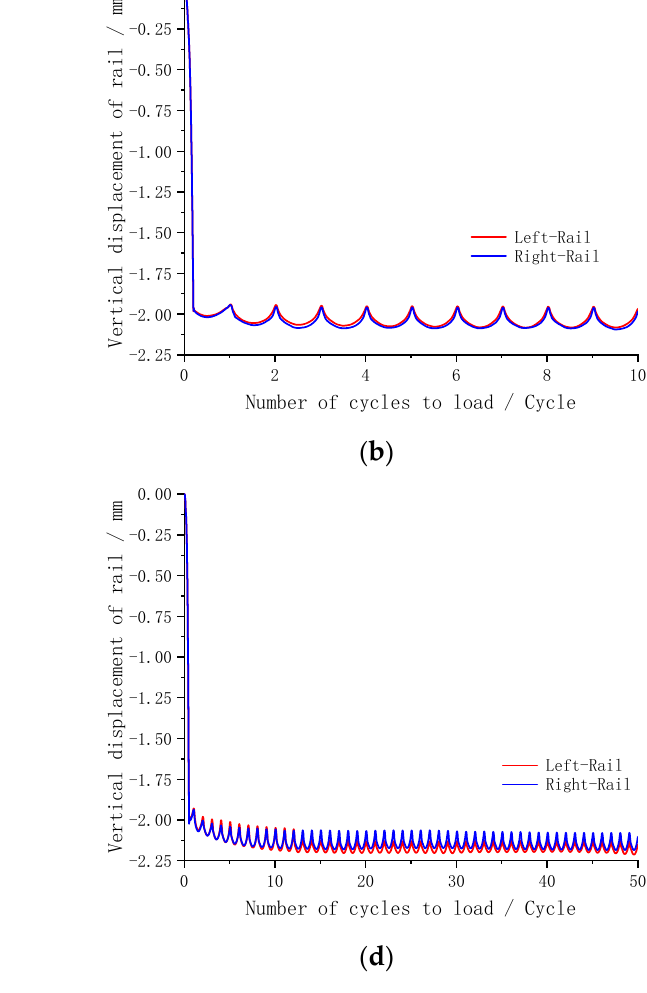
Figure 12. The vertical displacement curve of the rail. ( a ) 5 Hz. ( b ) 10 Hz. ( c ) 20 Hz. ( d ) 50 Hz. Comparing the vertical displacement curves of the rails under different loading frequencies in Figure 12, it can be seen that the change trends of the left and right rails were the same, the change curves were nearly overlapped, and the vertical displacement change curves of the left and right rails changed periodically with the cyclic load. The vertical displacement of the rail corresponding to 5 Hz was the smallest, approximately 2